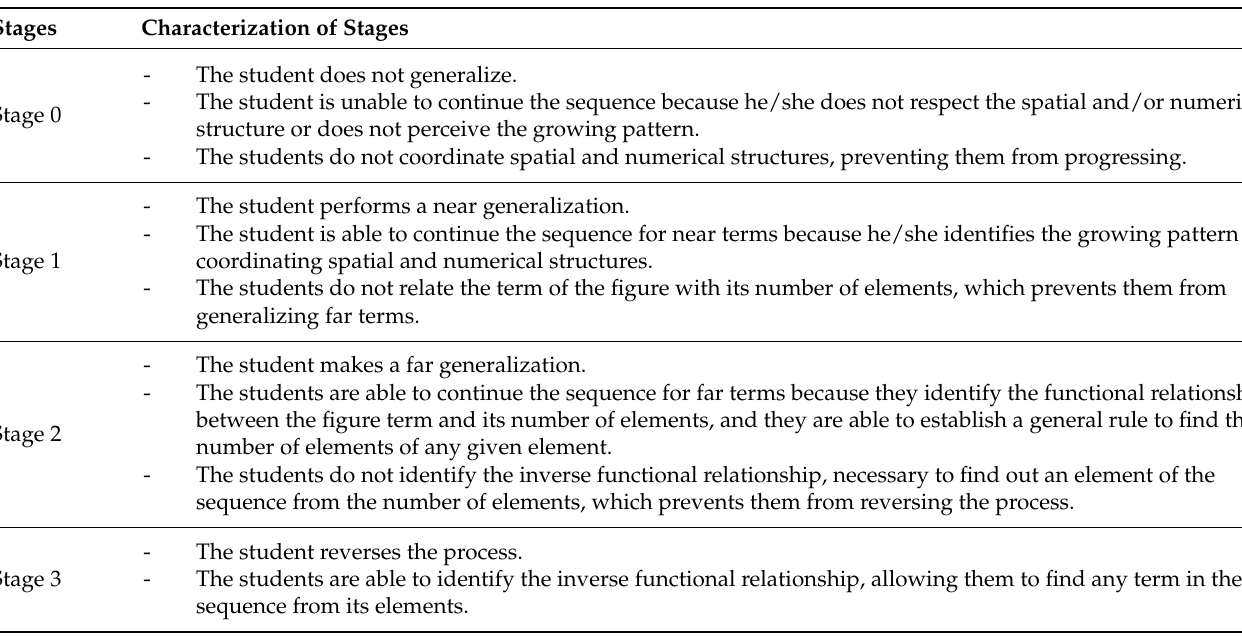
Table 1. Understanding stages of pattern generalization.